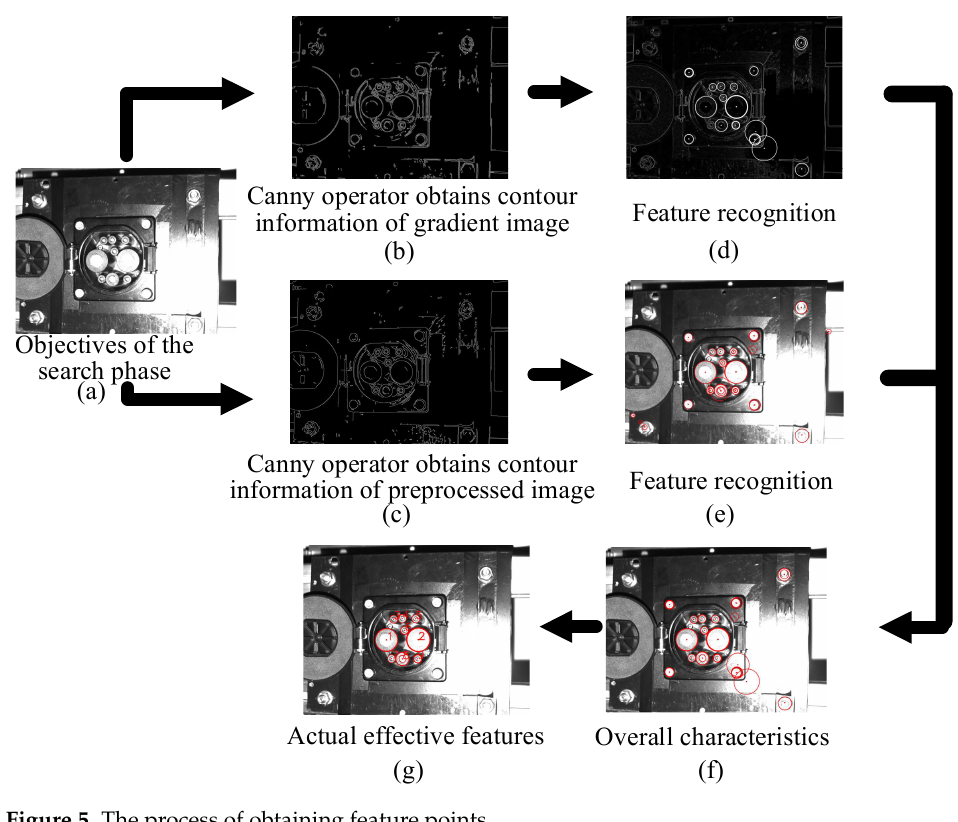
Figure 5. The process of obtaining feature points.